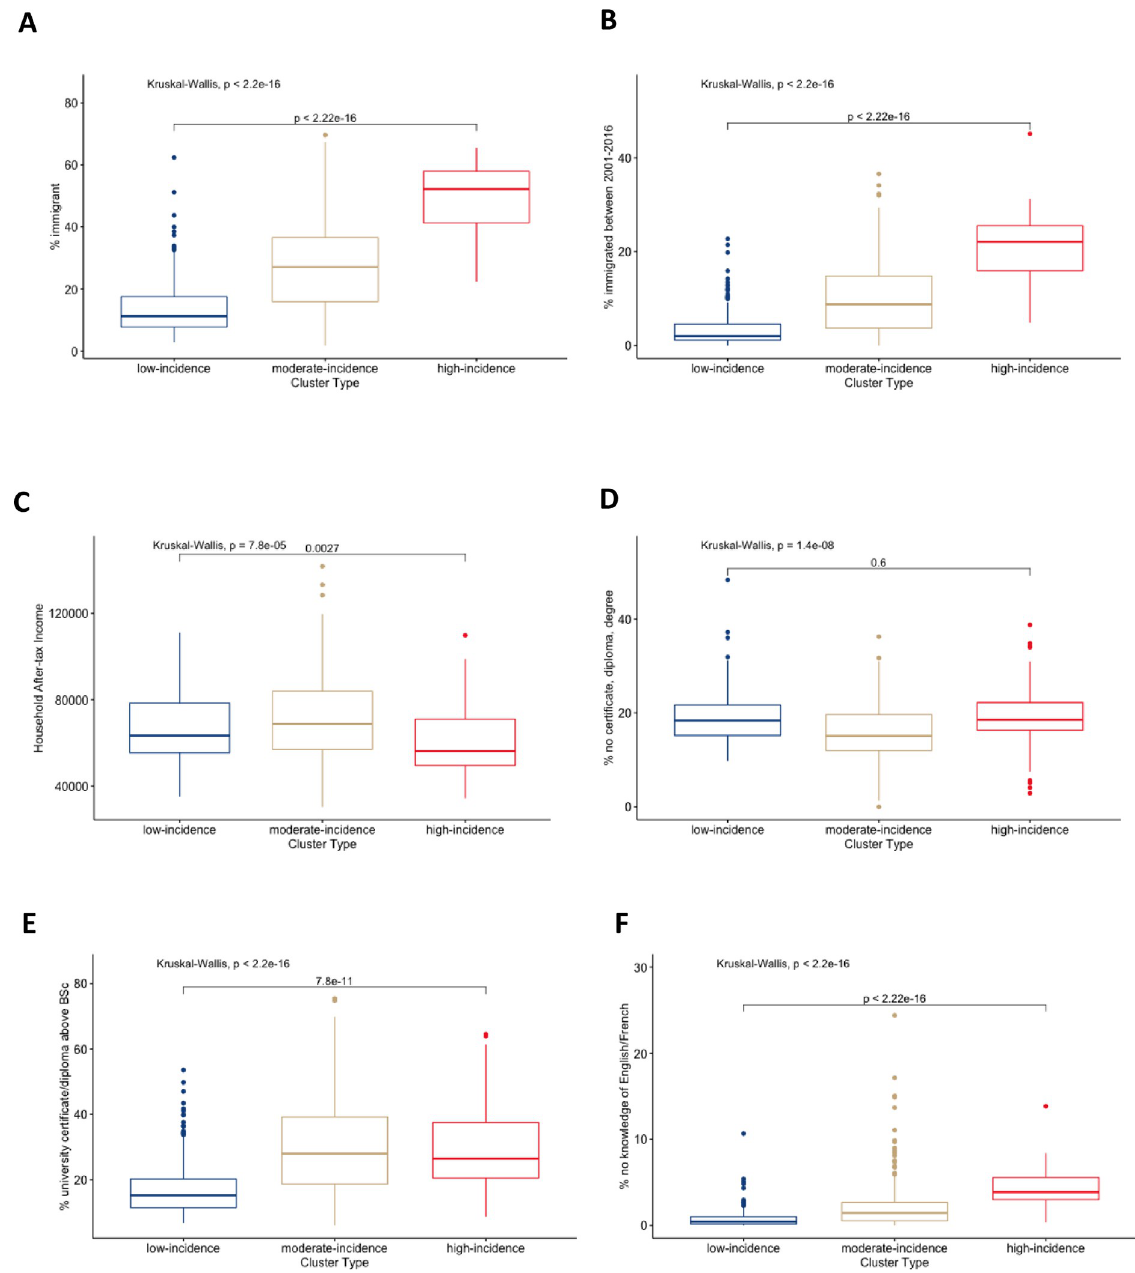
Fig 4. Characterizing high, moderate, and low-incidence clusters of travel-acquired illness burden across Ontario, Canada. Boxplots comparing clusters of FSAs across Ontario using key characteristics from the 2016 Census. Kruskall-Wallis and Wilcoxon rank sum tests were used as appropriate. All statistical tests were two-sided and a p-value of < 0.05 was considered